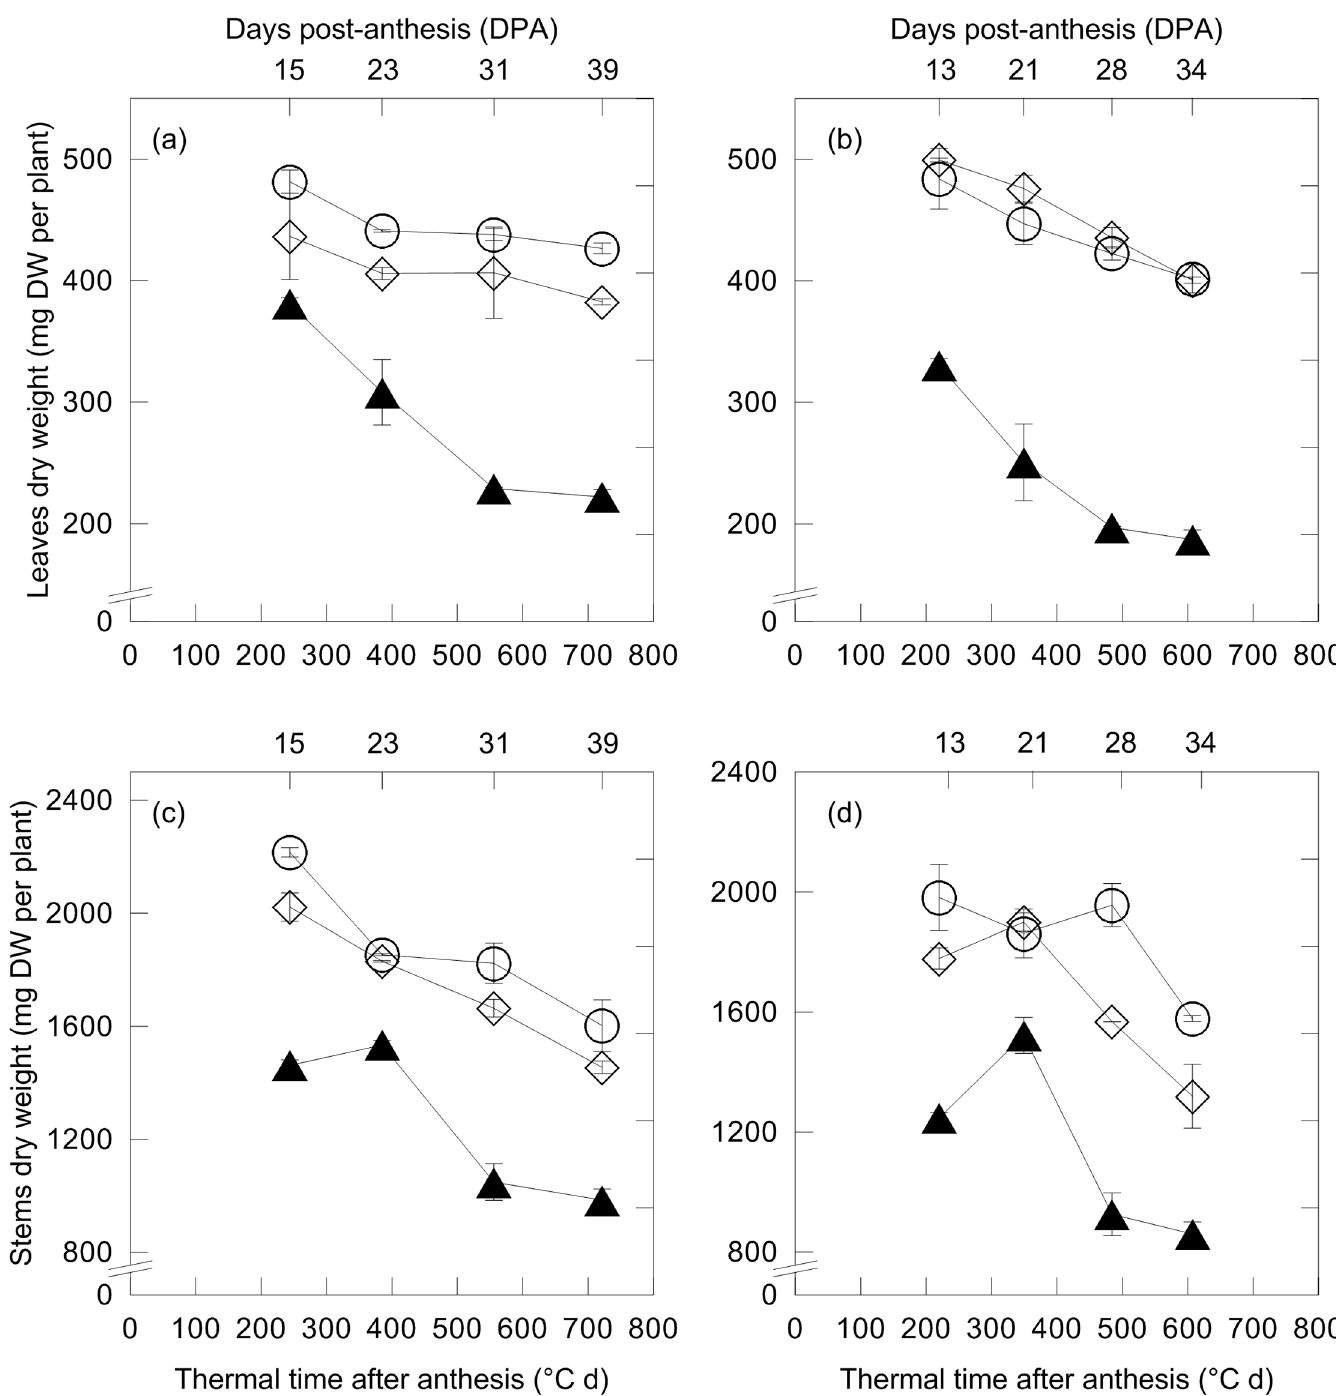
Fig 2. Changes of leaves dry weight (mg DW per plant) and stems dry weight (mg DW per plant) against thermal time after anthesis (cumulative average daily air temperature exceeding 0°C, °C d) and days post-anthesis (DPA) (above axis) of durum wheat in 2011 (a and c, respectively) and 2012 (b and d, respectively). Wheat plants were exposed to control conditions (unfertilized CONTROL, black triangle) and to two N fertilization treatments with urea (UREA, white rhombus) and calcium nitrate (NITRATE, white circle) at the rate of 150 kg N ha -1 (mean value ± standard errors, n = 3 independent replicates; split-plot ANOVA over thermal time after anthesis; effects: (a) treatment , P < 0.01; time , P < 0.01; treatment x time , P = 0.08; (b) treatment , P < 0.01; time , P < 0.01; treatment x time , P = 0.33; (c) treatment , P < 0.05; time , P < 0.01; treatment x time , P < 0.01; (d) treatment , P < 0.05; time , P < 0.01; treatment x time , P <